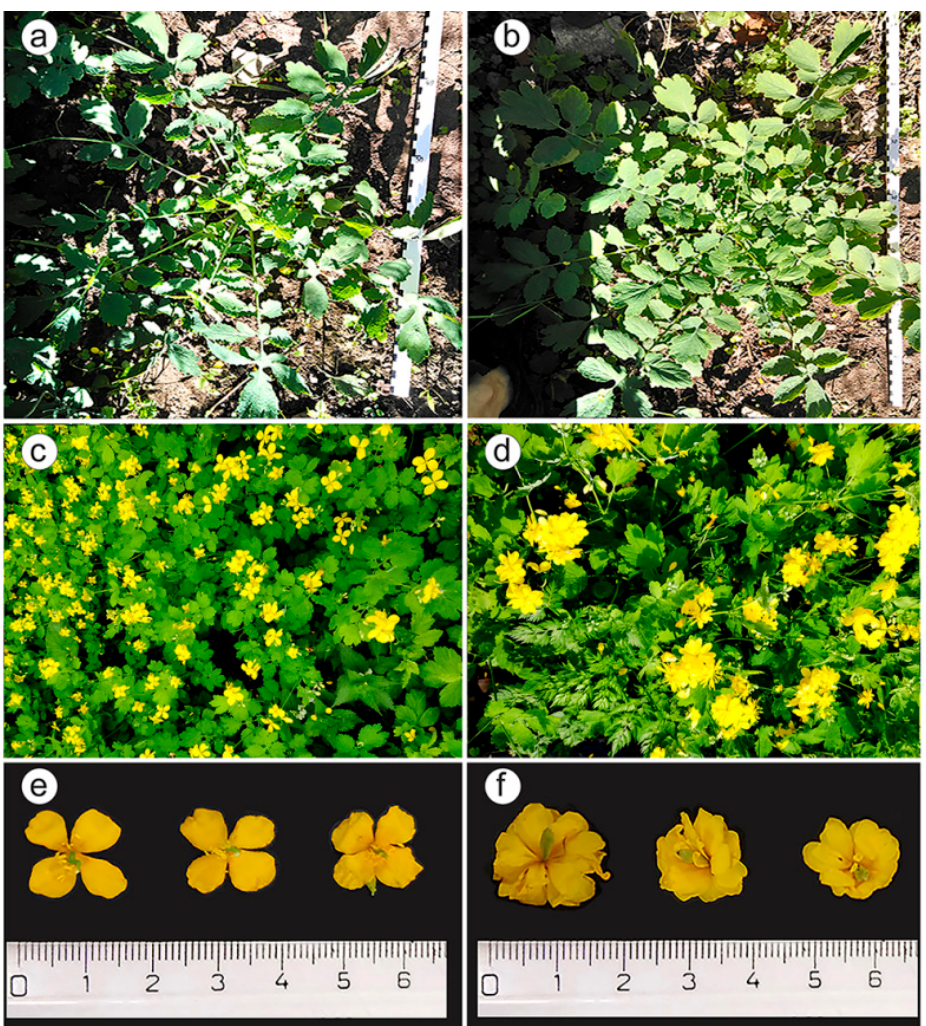
Figure 1. Chelidonium majus plants and inflorescences in the control normal-flowered (K 171-1) and double-flowered (K 211) populations. Plants in the rosette growth stage: ( a ) K 171-1, ( b ) K 211; flowering plants: ( c ) K 171-1, ( d ) K 211; inflorescences: ( e ) K 171-1, ( f ) K 211.